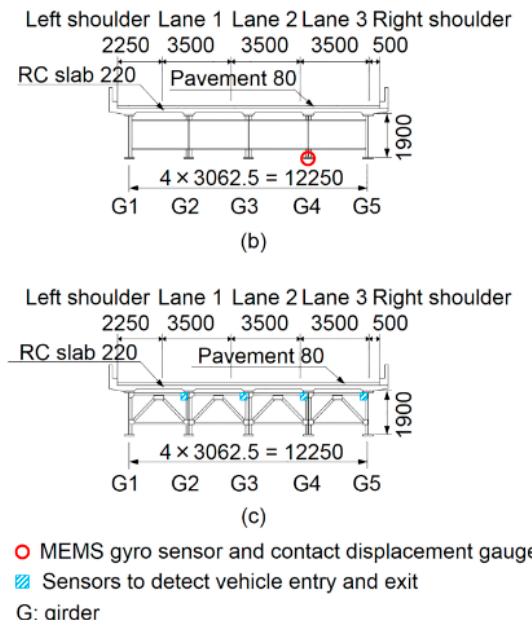
Figure 3. Test bridge used in our field measurements (units: mm): ( a ) top view; ( b ) front view at the longitudinal center of main girder; and ( c ) front view at the main girder edge.